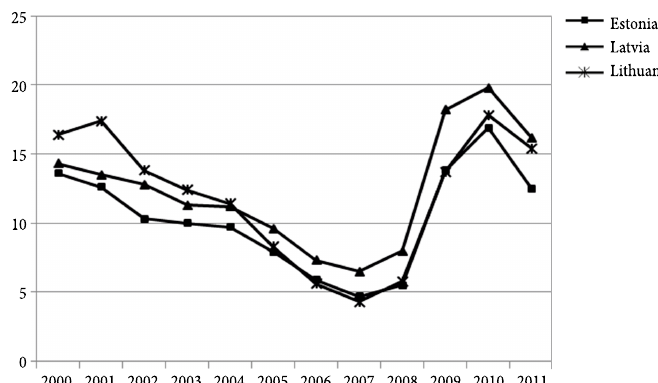
Fig. 1. Unemployment rates in the Baltic States (percentage) Source : Eurostat